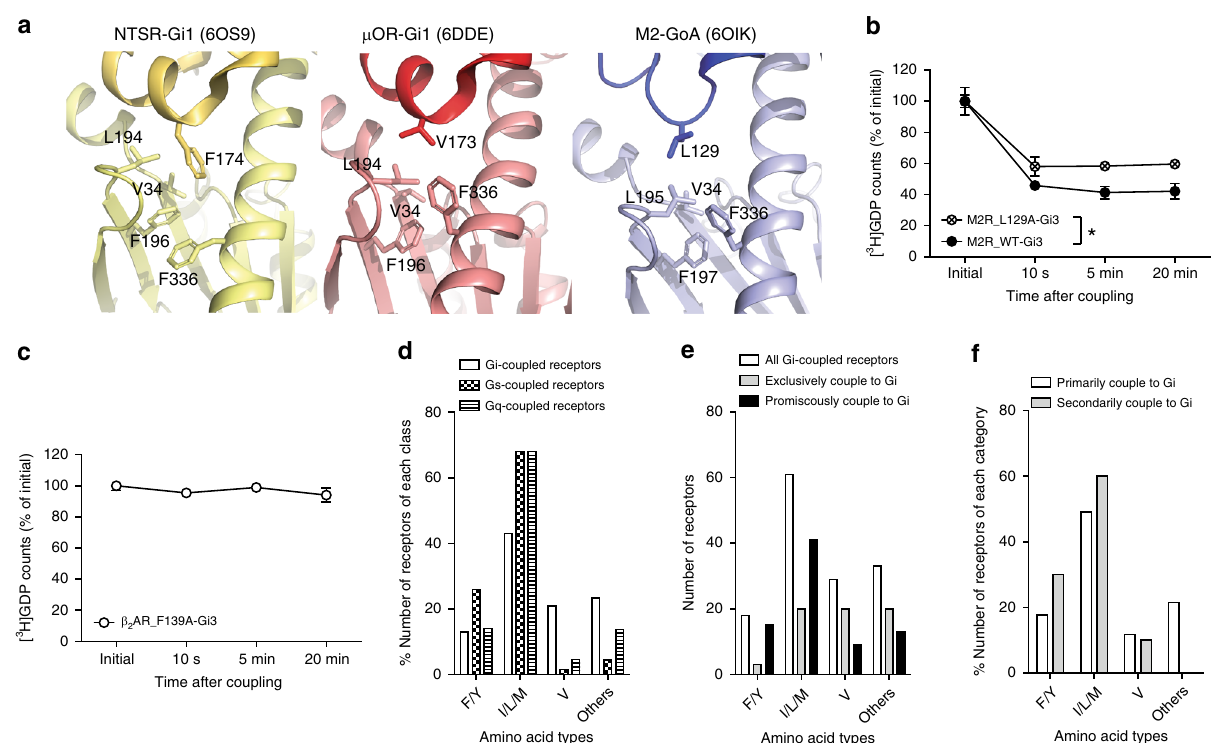
Fig. 5 The role of residue 34.51 within ICL2 in M2R-Gi3 and β 2 AR-Gi3 coupling. a The structures of ICL2 and hydrophobic pocket of neurotensin receptor-Gi1 complex (left, PDB 6OS9), mu-opioid receptor-Gi1 complex (middle, PDB 6DDE), and M2R-GoA complex (right, PDB 6OIK). Receptors are shown in dark color, and G proteins are shown in light color. b GDP release pro fi les of M2R-Gi3 and M2R_L129A-Gi3. c GDP release pro fi les of β 2 AR_F139A-Gi3. For ( b ) and ( c ), * indicates statistical differences between groups as analyzed by a two-tailed Student represent mean ± S.E.M of three independent experiments. Please note that the data is plotted using a non-linear/non-logarithmic scale. d Amino acid type analysis at residue 34.51 of type A GPCRs with known coupling G proteins. e Amino acid type analysis at residue 34.51 of type A Gi/o-coupled receptors subcategorized into exclusive or promiscuous coupling. f Amino acid type analysis at residue 34.51 of promiscuously Gi/o-coupled receptors, which are subcategorized into primary and secondary coupling. Source data are provided as a Source data fi